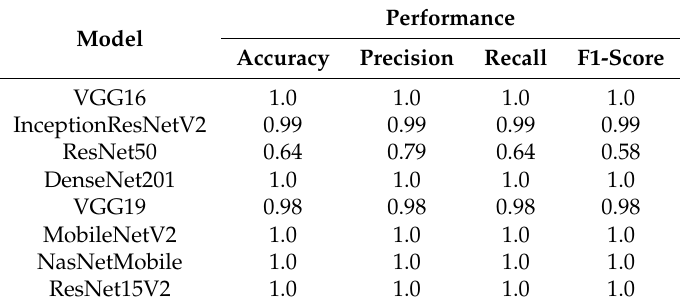
Table 4. Overall model’s performance on X-ray train set.